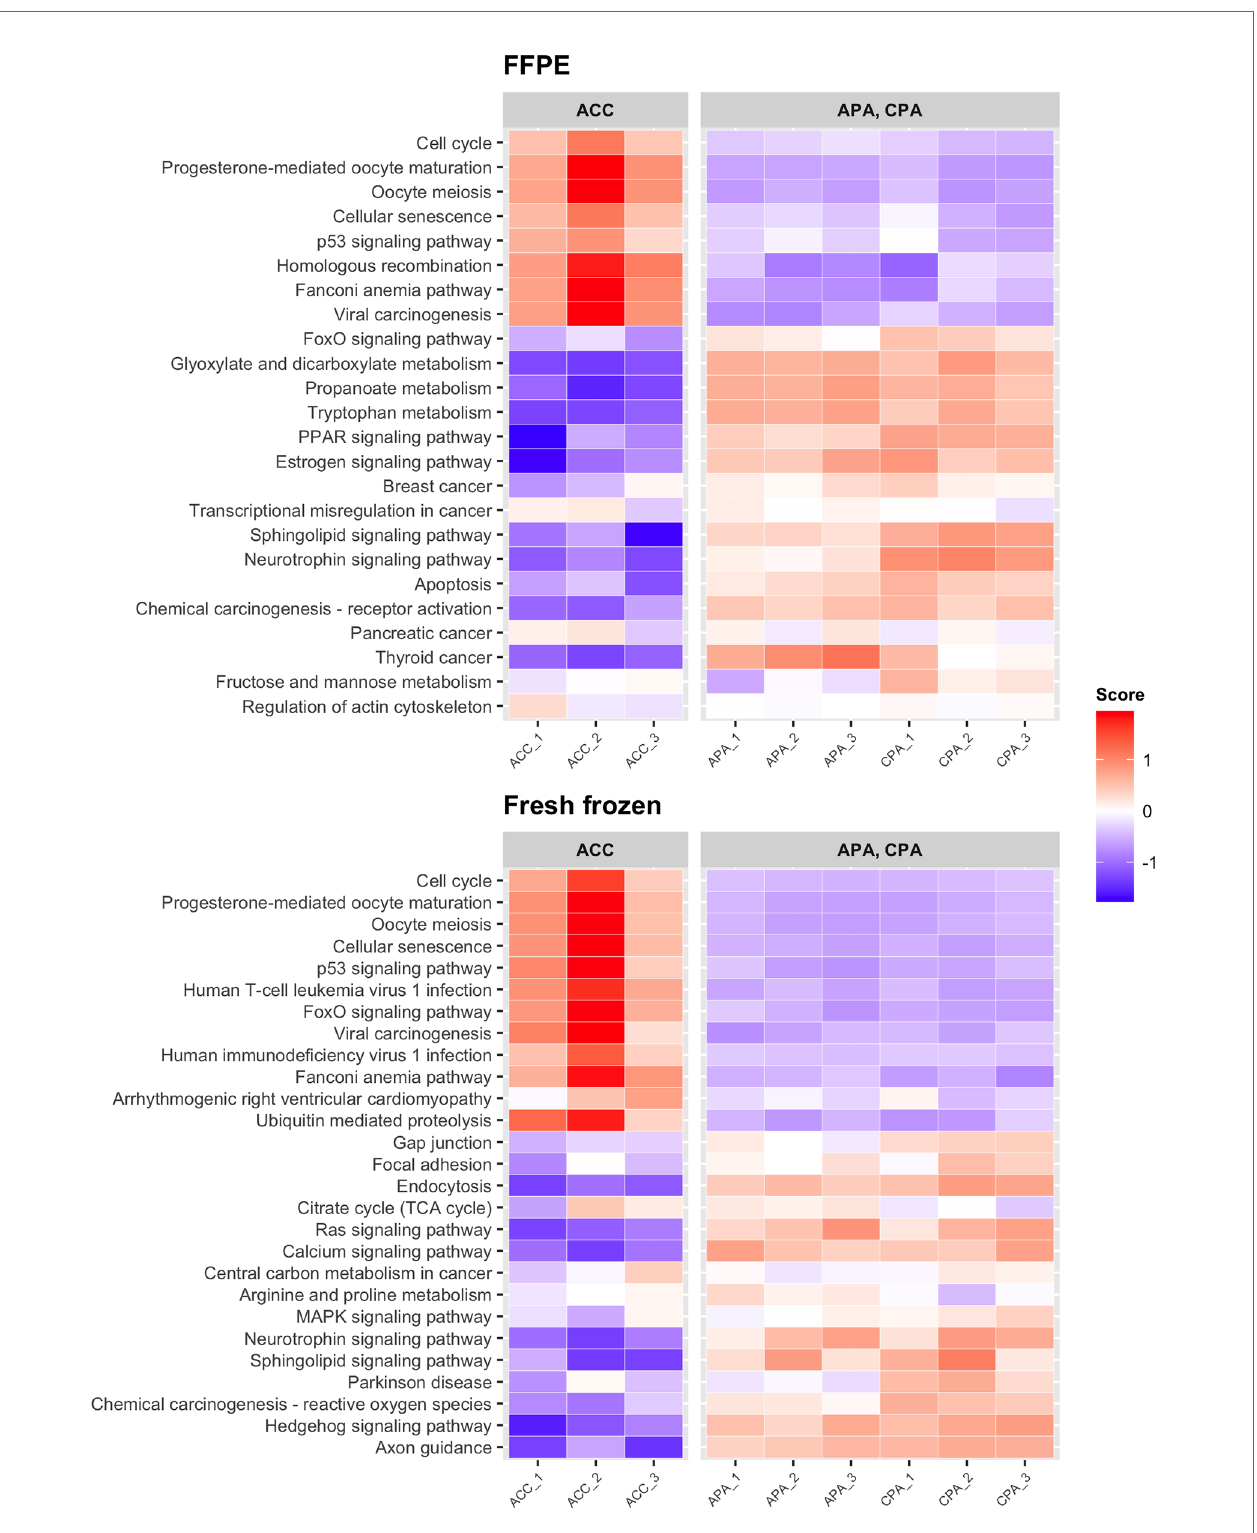
FIGURE 3 | Heatmap showing the results of KEGG pathway analysis of DEGs detected between ACC and APA-CPA by each storage type. Score; the agglomerated z score of each enriched KEGG pathway per